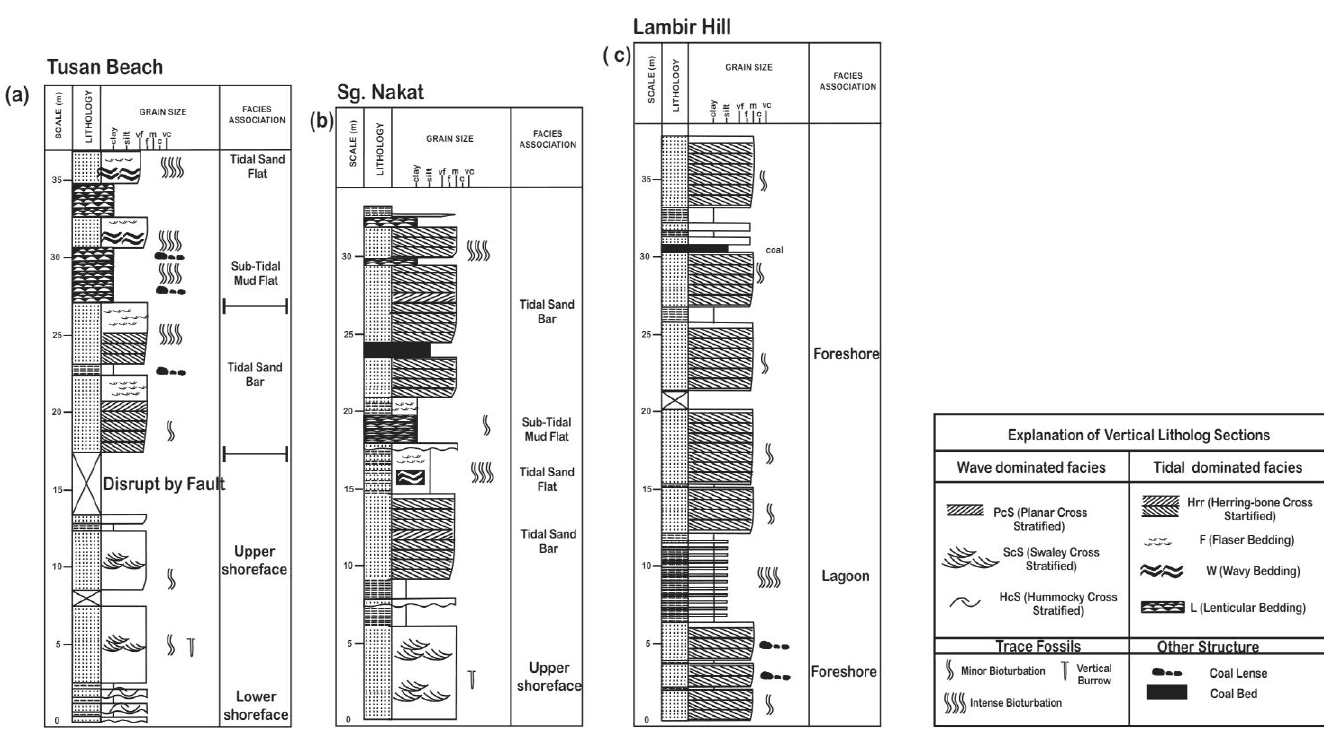
Figure 2: (a) Diagram showing the vertical litholog of Tusan Beach representing wave to tidal facies association. (b) Diagram showing the vertical litholog analysis of Sg. Nakat, near to Lambir Hill, illustrated partition of wave-tide dominated environment. (c) Diagram showing the vertical litholog of Lambir Hill comprised of planar cross stratified representing foreshore